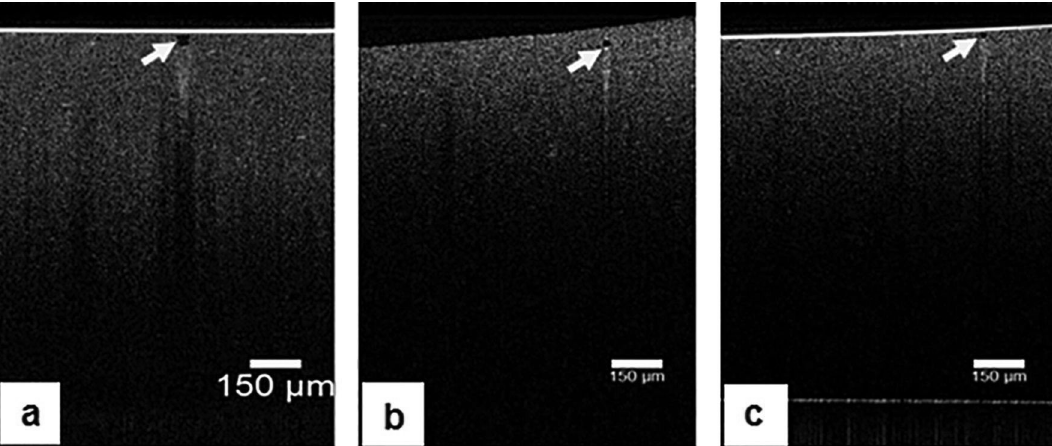
FIGURE 5 - Tomographic images of the emulsified systems (1:50 dispersion in purified water); where (a) ES-1, (b) ES-2 and (c) ES-3. The arrows indicate possible droplets of the emulsion’s inner phase.